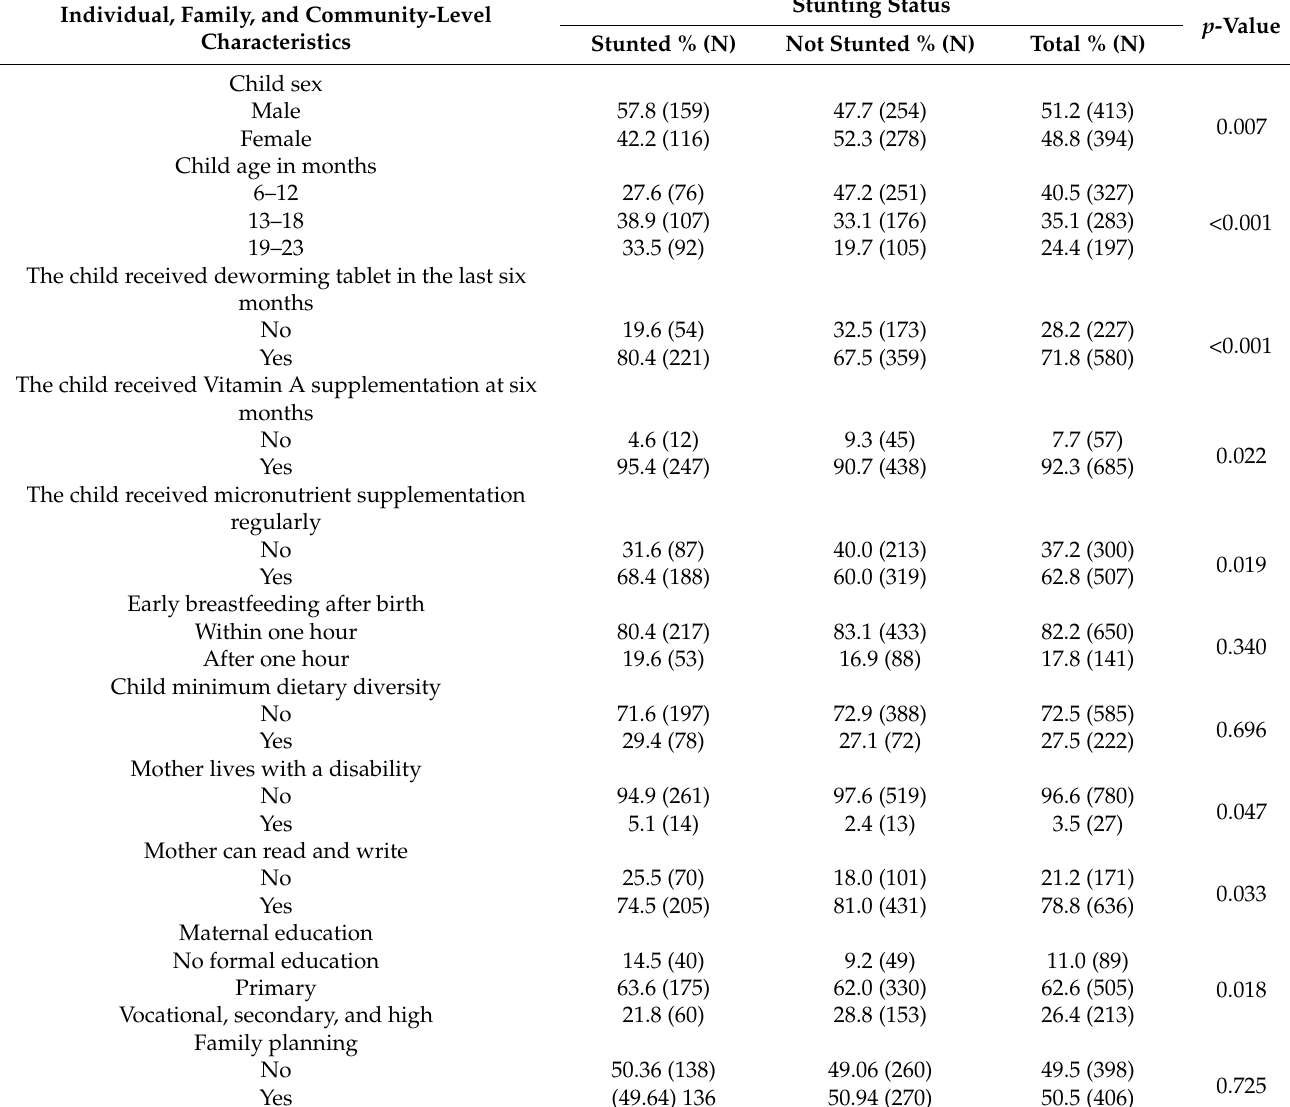
Table 1. Bivariate analysis: stunting and individual, family, and community-level factors.